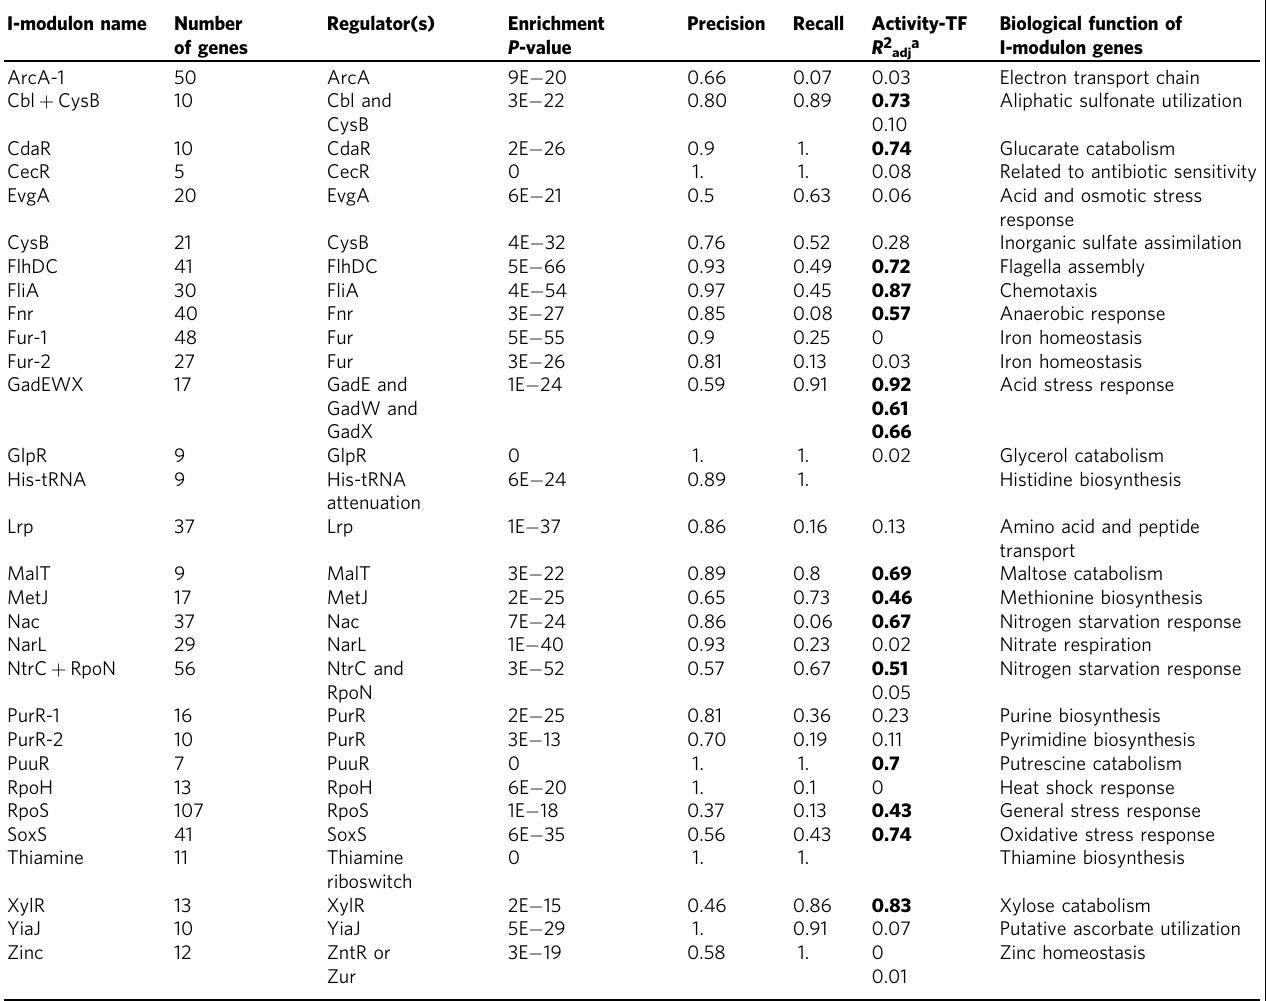
Table 1 Summary of 30 selected regulatory